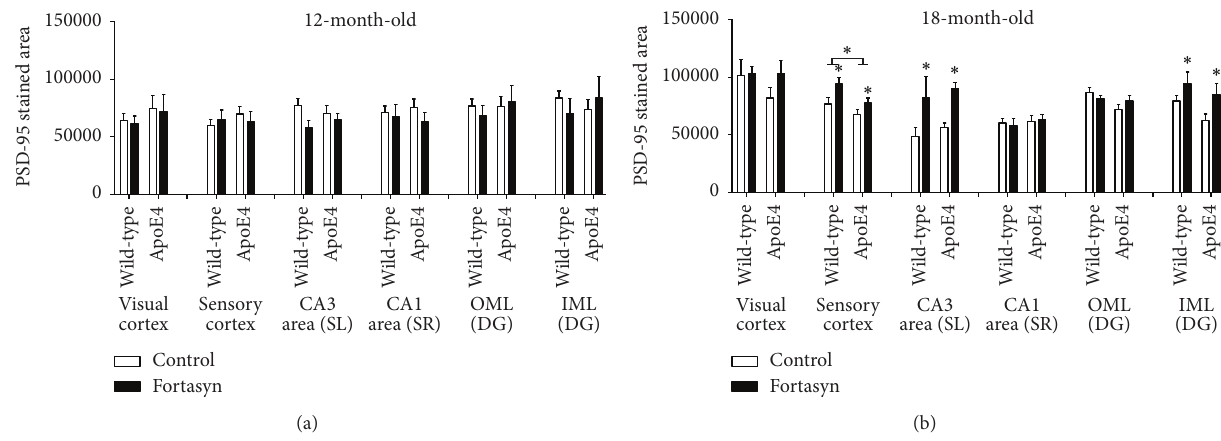
Figure 7: Levels of postsynaptic density-95 (PSD-95) in various brain areas in wild-type mice and apoE4 mice on either control diet or Fortasyn diet. (a) At 12 months, we did not find significant differences between groups. (b) At 18 months, reduced PSD-95 levels were seen in the sensory cortex of apoE4 mice compared to wild-type mice ( 𝑝 = 0.021 ). Fortasyn diet increased levels of PSD-95 in the sensory cortex ( 𝑝 = 0.014 ), CA3 area ( 𝑝 = 0.004 ), and IML ( 𝑝 = 0.004 ), irrespective of genotype. No genotype × diet interactions were observed. ∗ 𝑝 ≤ 0.05 ; ∗∗ 𝑝 ≤ 0.01 ; ∗∗∗ 𝑝 ≤ 0.001